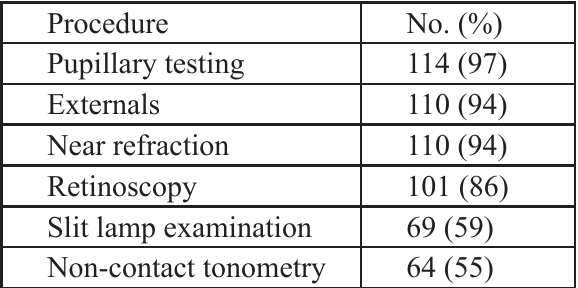
Figure 1: The percentages in descending order of practices pos - sessing each of the listed equipment. Only 33% and 7% respec - tively possessed visual field analysers and corneal topographers. Tonometer is non-contact methods in this figure. Table 1: Procedures that should be routinely performed, the number and percentage of practitioners who reported perform - ing